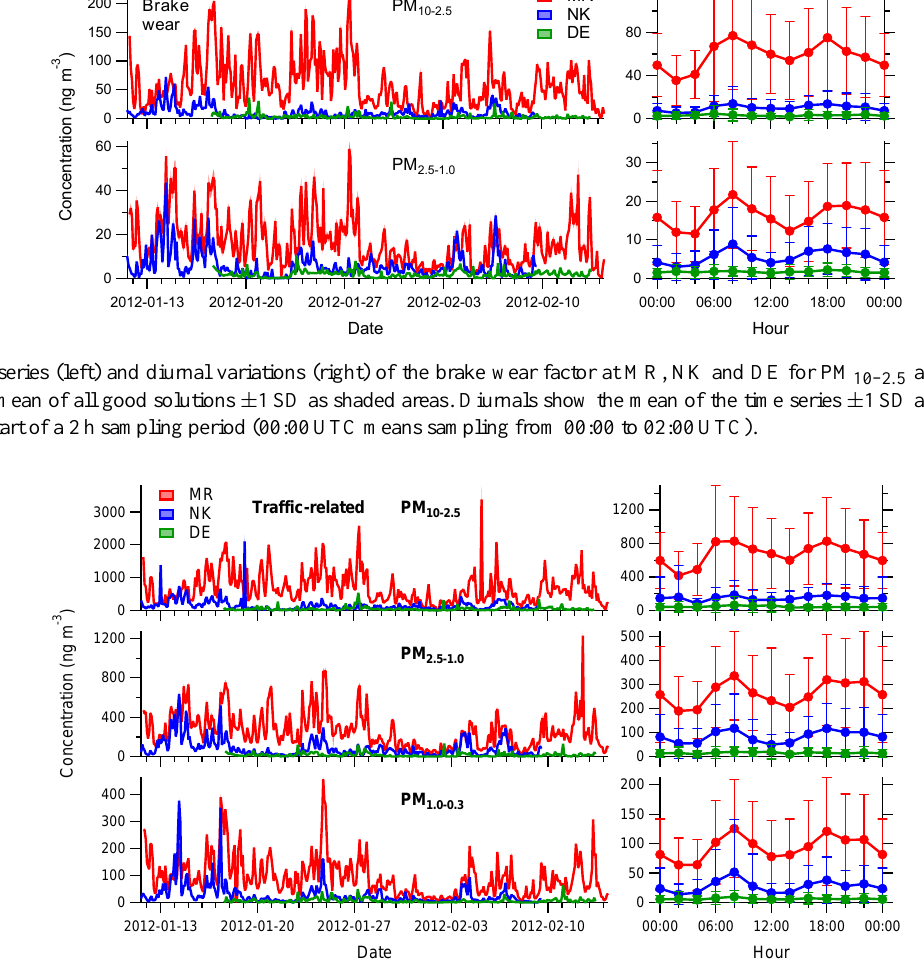
Figure 5. Time series (left) and diurnal variations (right) of the other traffic-related factor at MR, NK and DE for PM 10–2 . 5 , PM 2 . 5–1 . 0 and PM 1 . 0–0 . 3 . Time series show the mean of all good solutions ± 1SD as shaded areas. Diurnals show the mean of the time series ± 1SD as whiskers, with the hour being the start of a 2h sampling period (00:00UTC means sampling from 00:00 to